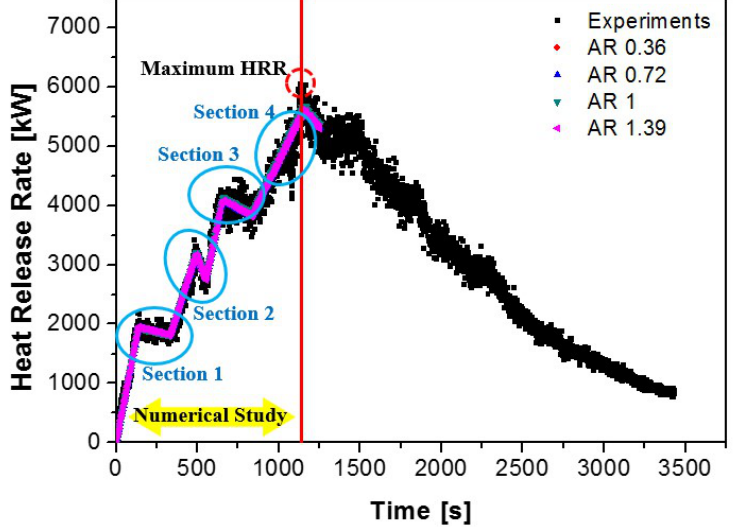
Figure 2. Heat release rate (HRR) results from experiments and numerical studies.